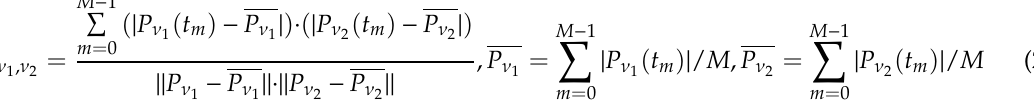
( b ) Figure 4. Evolution of the spectral amplitude modulus at the difference frequency dif ν = 0.4 (black line, signal 2 ( ) inc E t ) and basic one base ν = (0.8, 1.2) ( a ), and (1.8, 1.4) ( b ) (blue and red lines, signal ( ) inc E t ), respectively. When comparing the spectral line dynamics, one can see that the contribution of various basic frequencies to generation process changes in different time intervals. Accordingly, one can see in